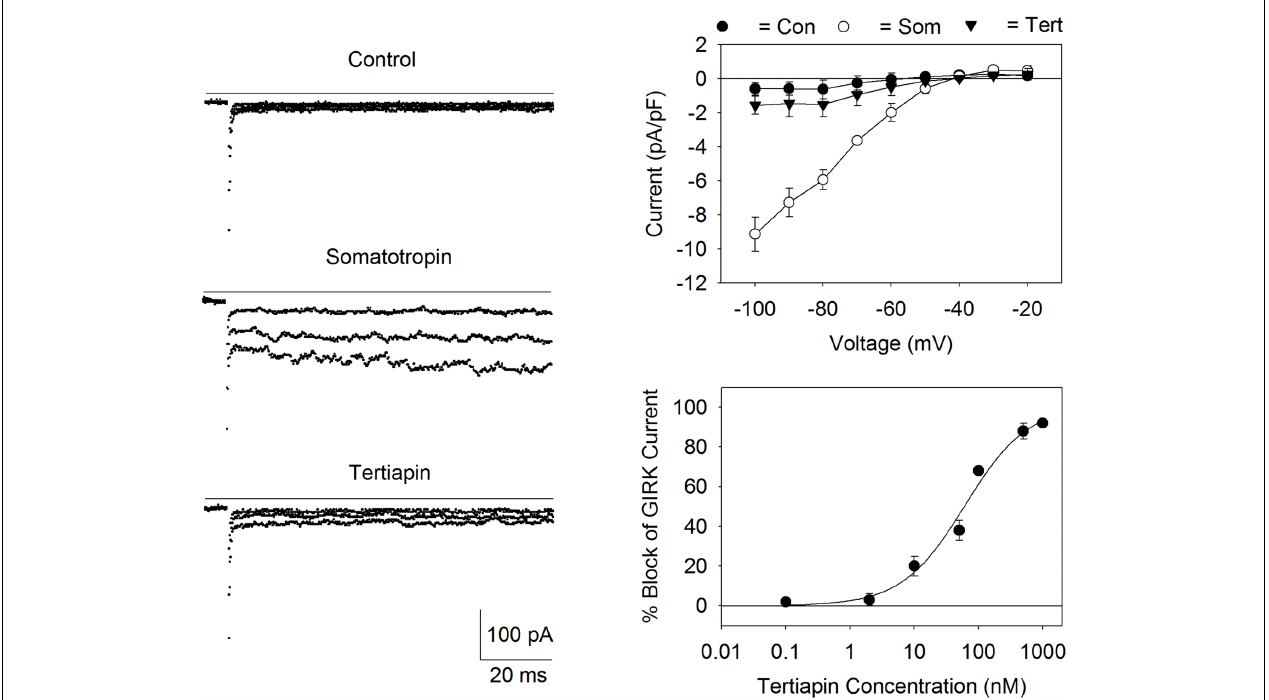
− 40mV. Current values were obtained by subtracting the currents by records obtained in the presence of 1mM BaCl 2 . Each point represents the mean ± SE current (pA/pF) measured in three to five cells. Bottom right panel: dose versus response curve for tertiapin-Q block of the AtT20 cell GIRK current. Each point represents the mean ± SE inhibition obtained from three to six experiments.The calculated IC 50 value for tertiapin-Q block was 60nM.